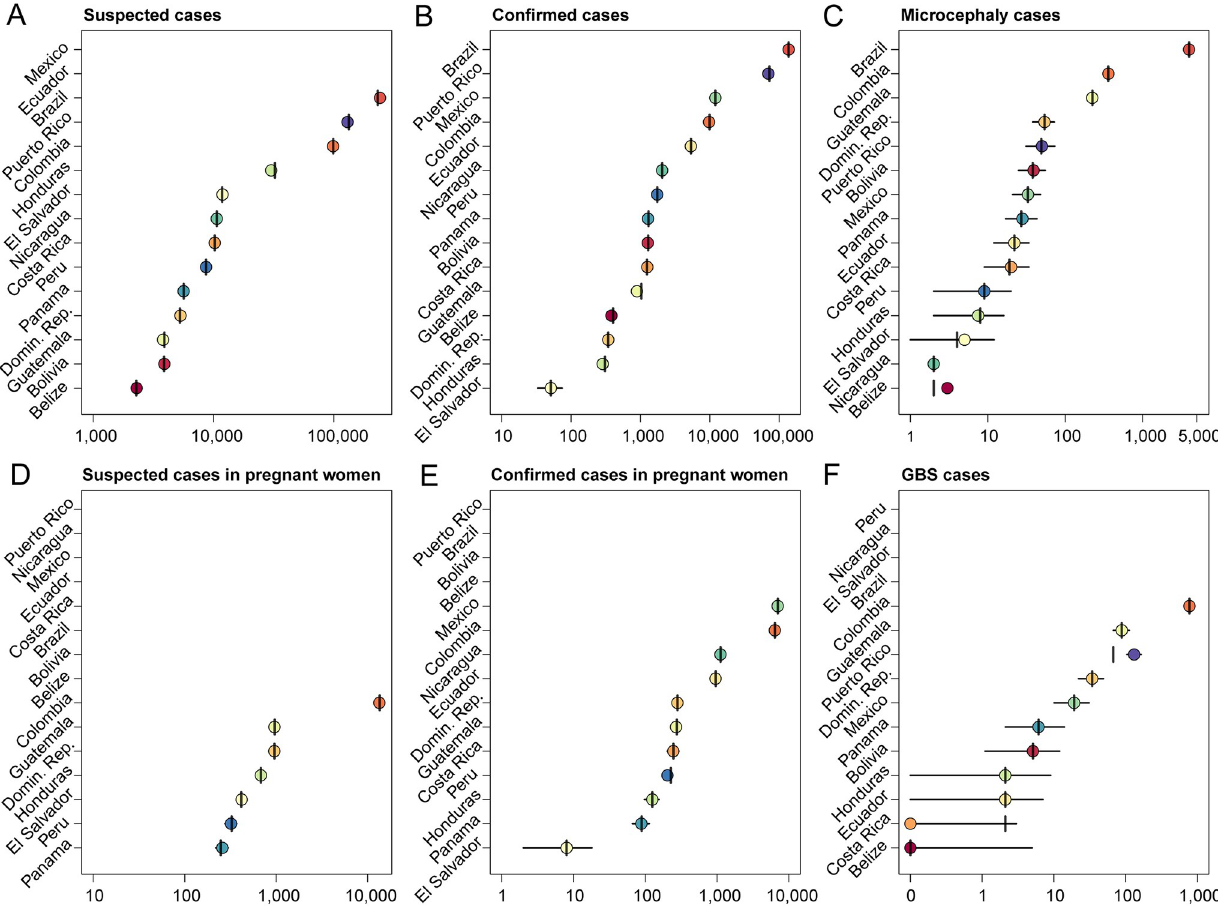
Fig 5. Posterior predictive checks at the national level for each data type used in the Bayesian models. Vertical lines are the observed cases and circles are the predicted number of cases with 95% credible intervals for each country and data type.